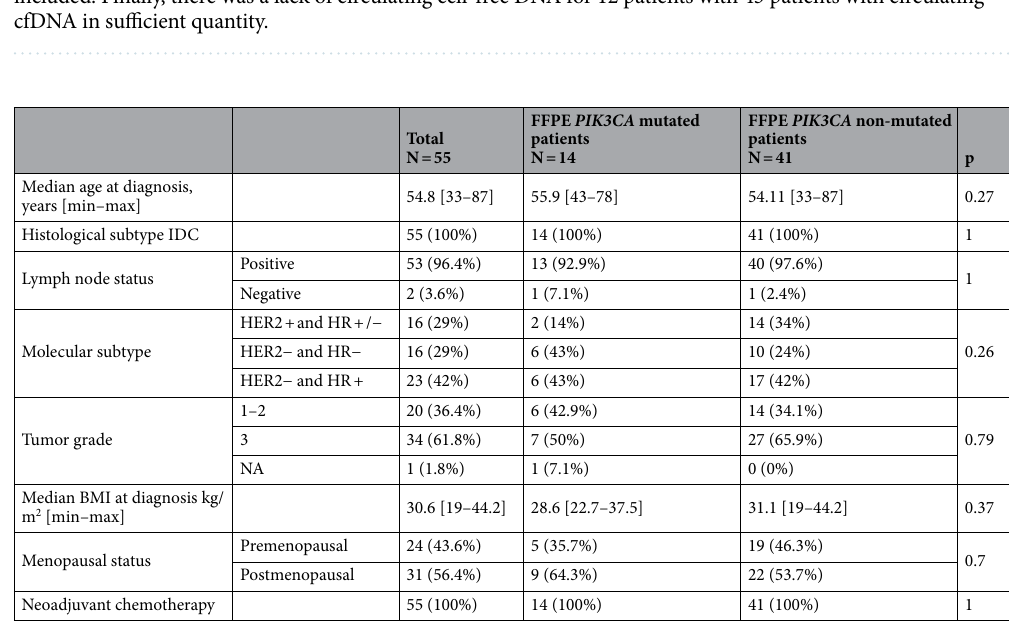
Table 1. Characteristics. HER2 + HER2 positive, defined as 3 + overexpression by immunohistochemical testing or 2 + with HER2 amplification by fluorescent in-situ hybridization, HR hormone receptor, BMI body mass index, NA non available, IDC invasive ductal